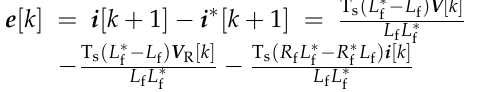
Figure 4. The change of permeability of L material: ( a ) L Relationship between material permeability and temperature; ( b ) L Relationship between material permeability and frequency.